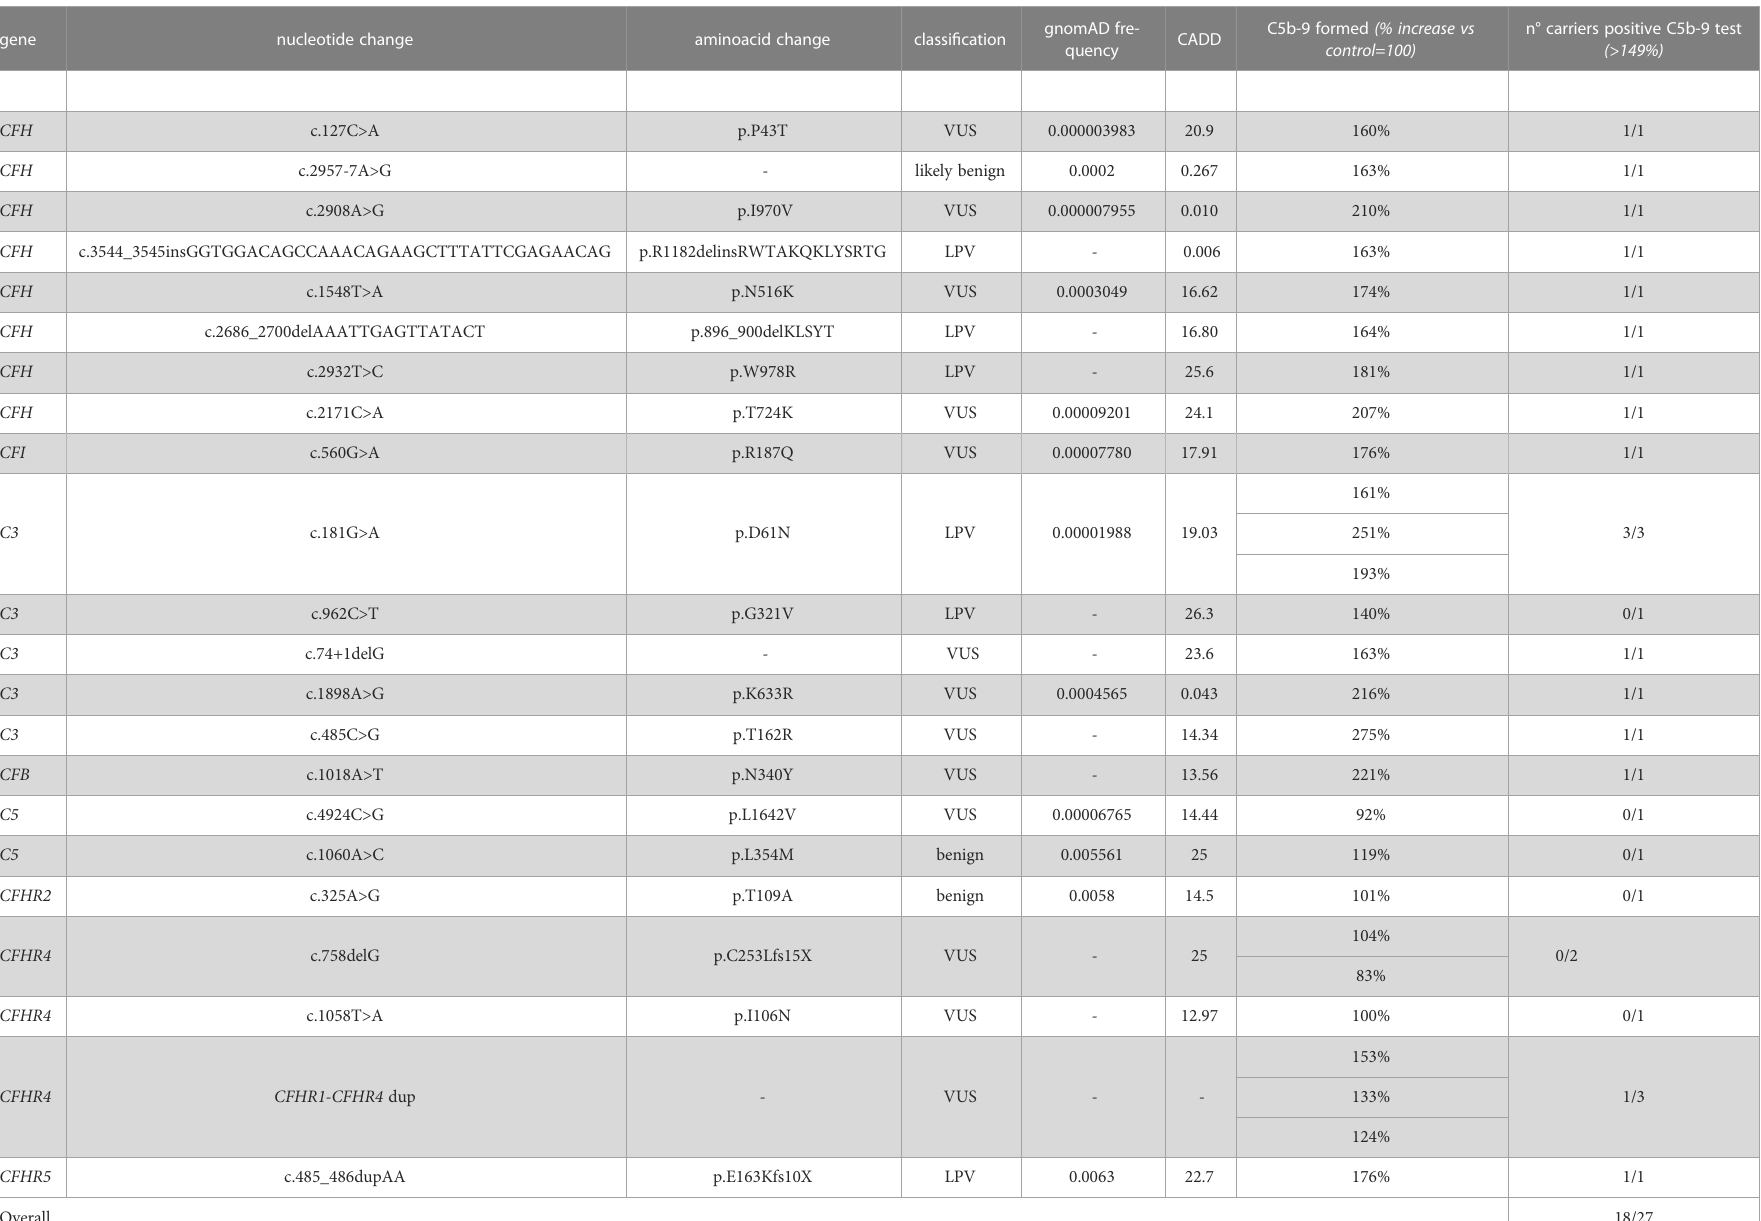
TABLE 5 Results of C5b-9 formation test in family members who carry VUS/LPV/LBV or benign